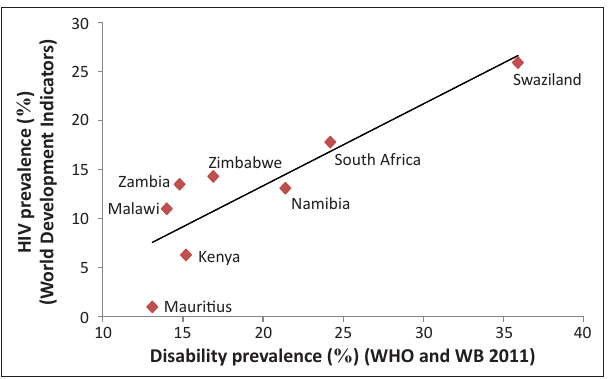
FIGURE 2: Disability and Gross National Income in Eastern and Southern Africa.